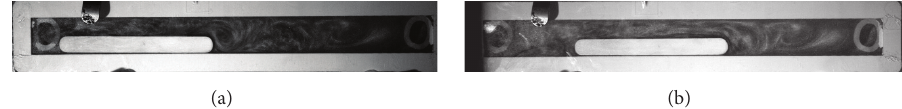
Figure 6: The body in the vibrating container in the extreme positions of the last, 𝑏 = 33.4 mm, 𝑓 = 12.7 Hz, ] = 0.13 St.